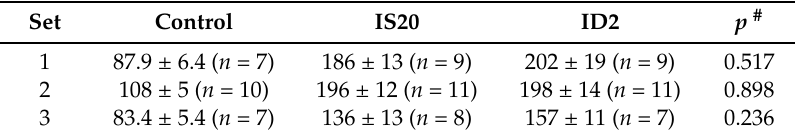
Table 3. Mean number of apoptotic events ( ± SEM) obtained in the control, IS20 and ID2 groups from 3 sets of experiments. n : numbers of embryos involved in the analyses. # p values obtained by comparing the IS20 and ID2 groups using two-tailed t -test.